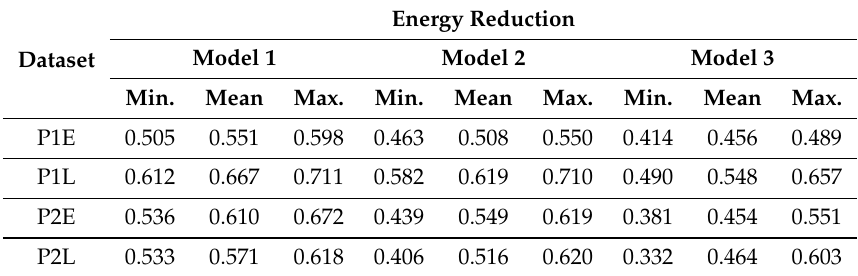
Figure 11. Total energy consumption regarding each evaluated model, the images resized to 25% of their original sizes, and the original (full-size) images from the ( a ) P1E, ( b ) P1L, ( c ) P2E, and ( d ) P2L datasets. Table 4. Minimum, mean, and maximum energy reduction rates induced by our ARIMs compared to the provided